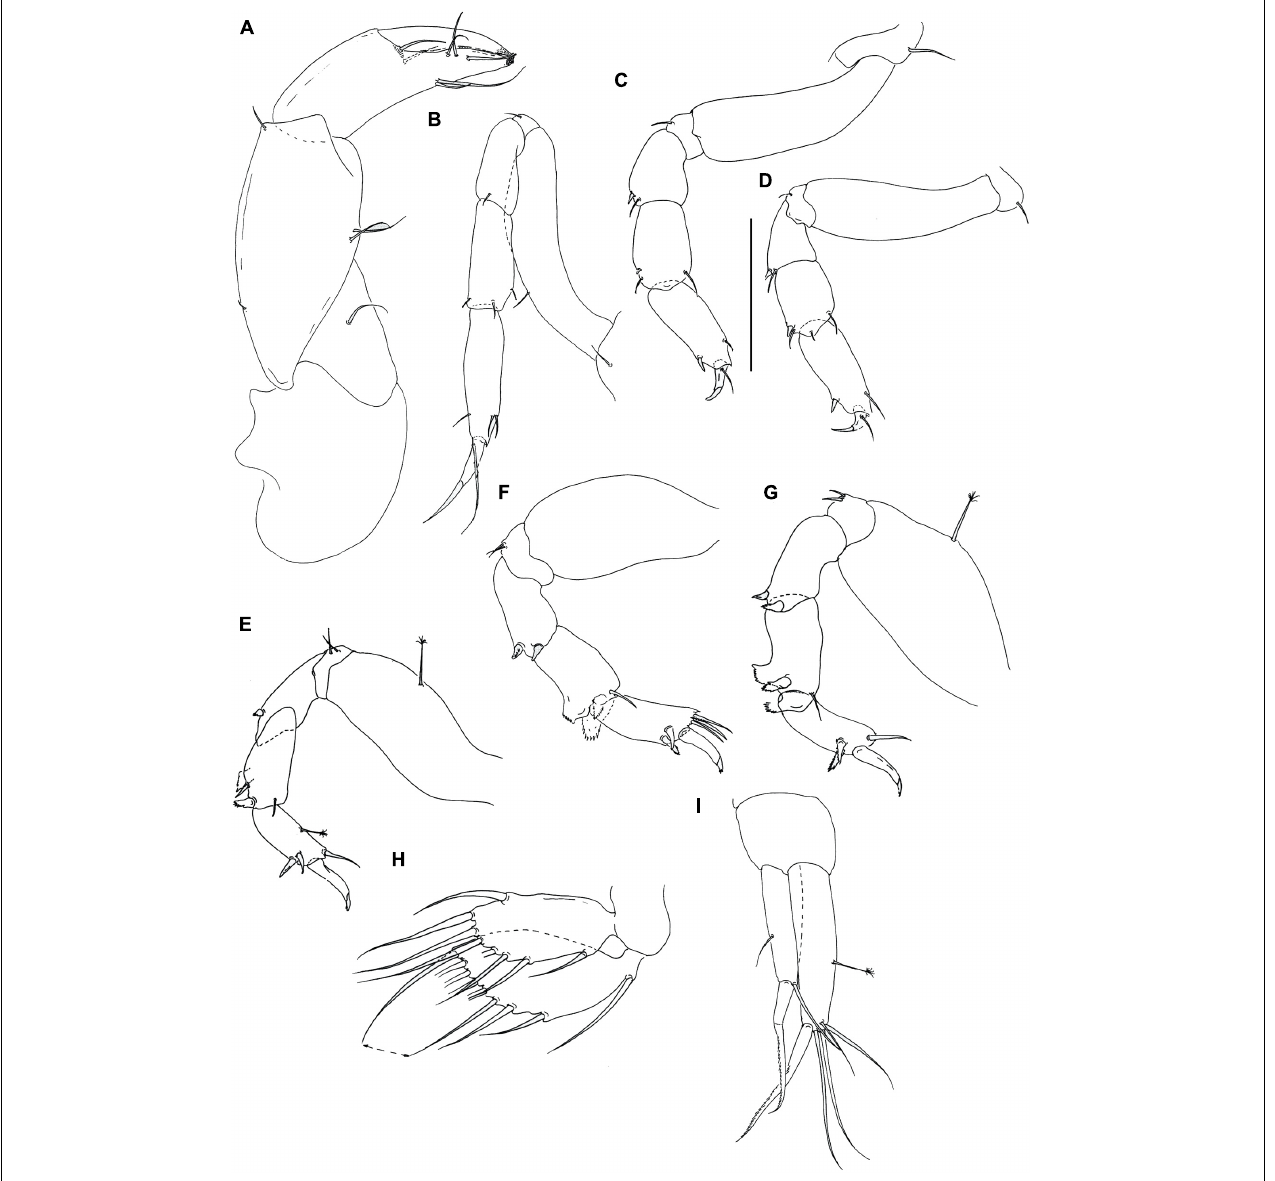
FIGURE 12 | Rakaduta inexcessis n. sp. (J57983) (A) cheliped; (B) pereopod-1; (C) pereopod-2; (D) pereopod-3; (E) pereopod-4; (F) pereopod-5; (G) pereopod-6; (H) pleopod; (I) uropod. Scale: panels (A–I) = 0.1 mm.